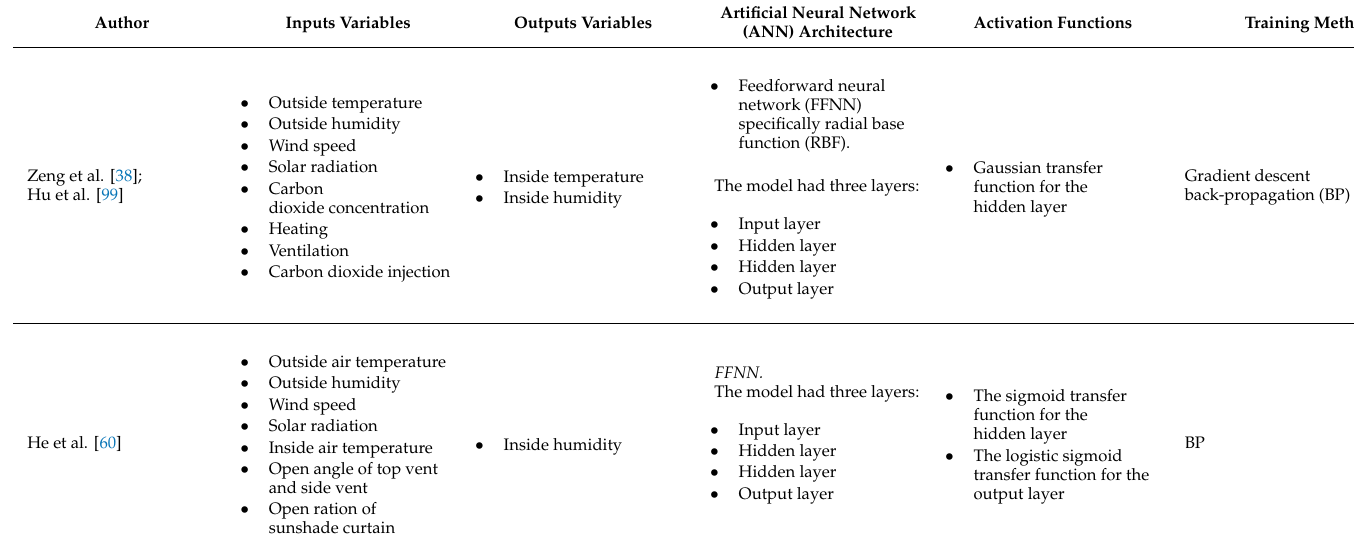
Table 2. Applications of feedforward neural network models for prediction of microclimate in